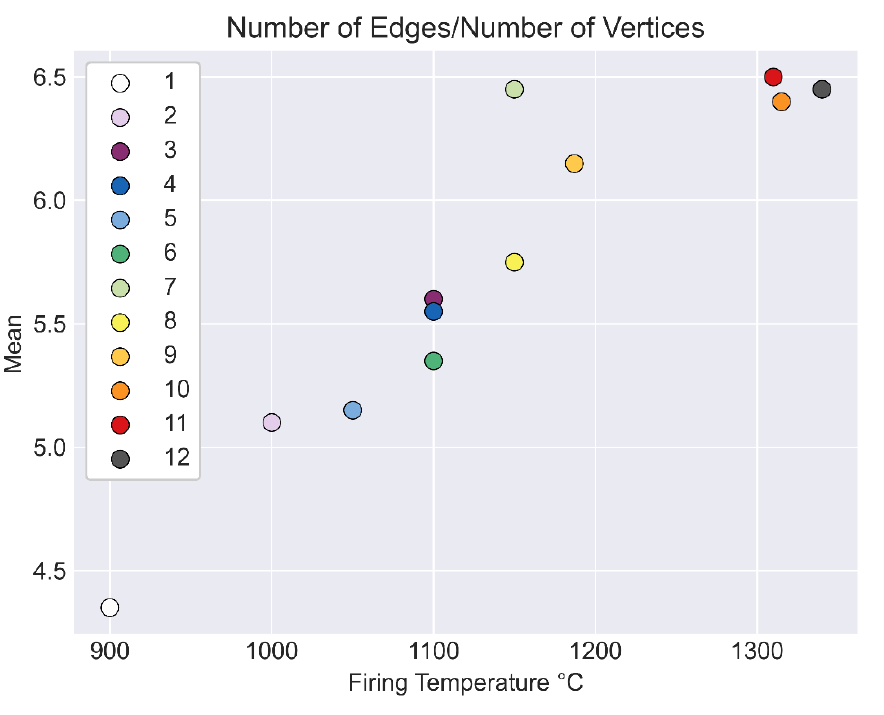
Figure 17. The ratio of edges to vertices rises with increased firing temperature. Points are the mean of